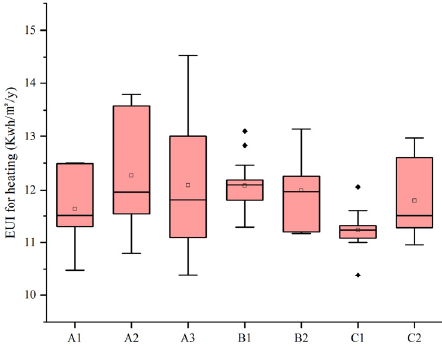
Figure 17. Distribution characteristics of EUI for cooling in different typologies of office blocks.